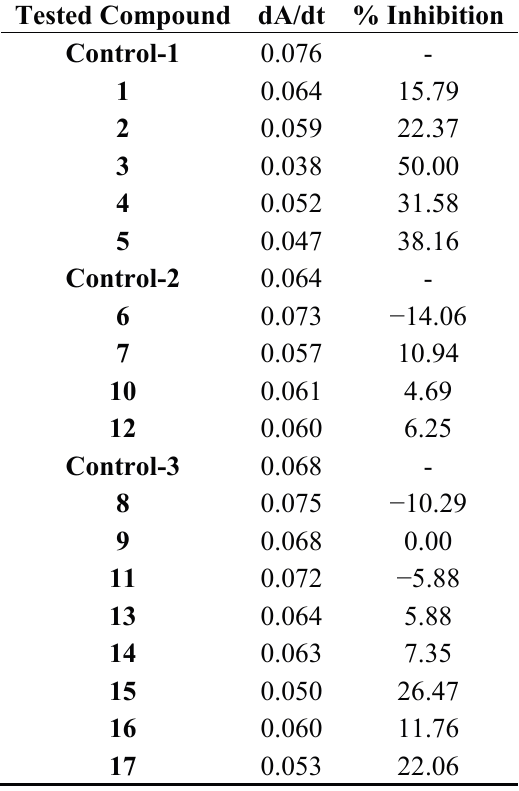
Table 2. Inhibition (%) of electron transfer of the tested chalcones (100 µM) to Pf